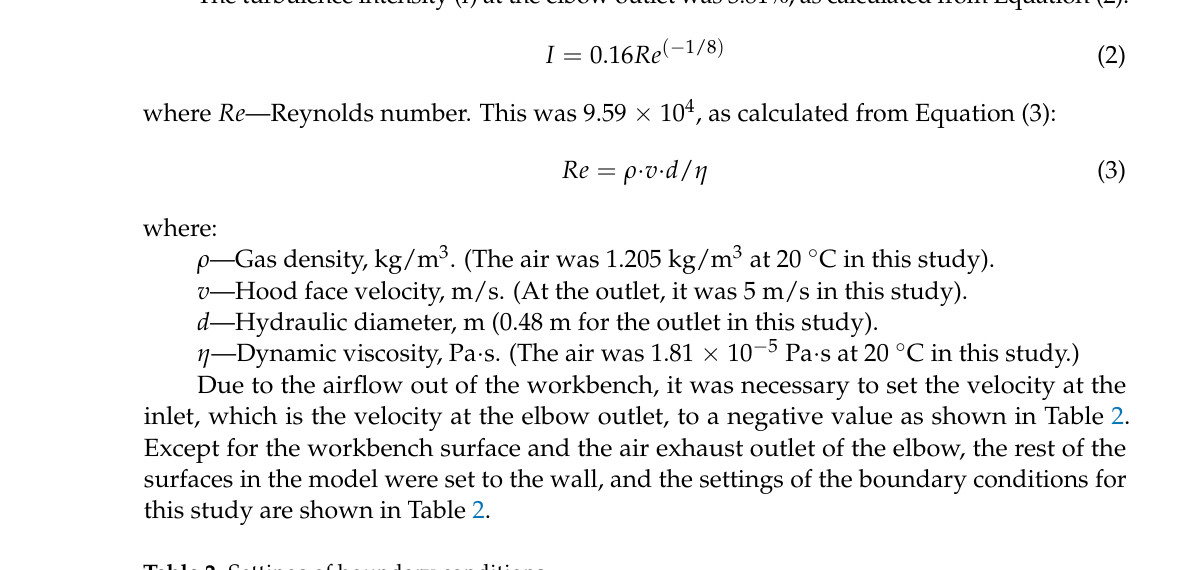
Table 2. Settings of boundary conditions. Boundary Conditions Parameter